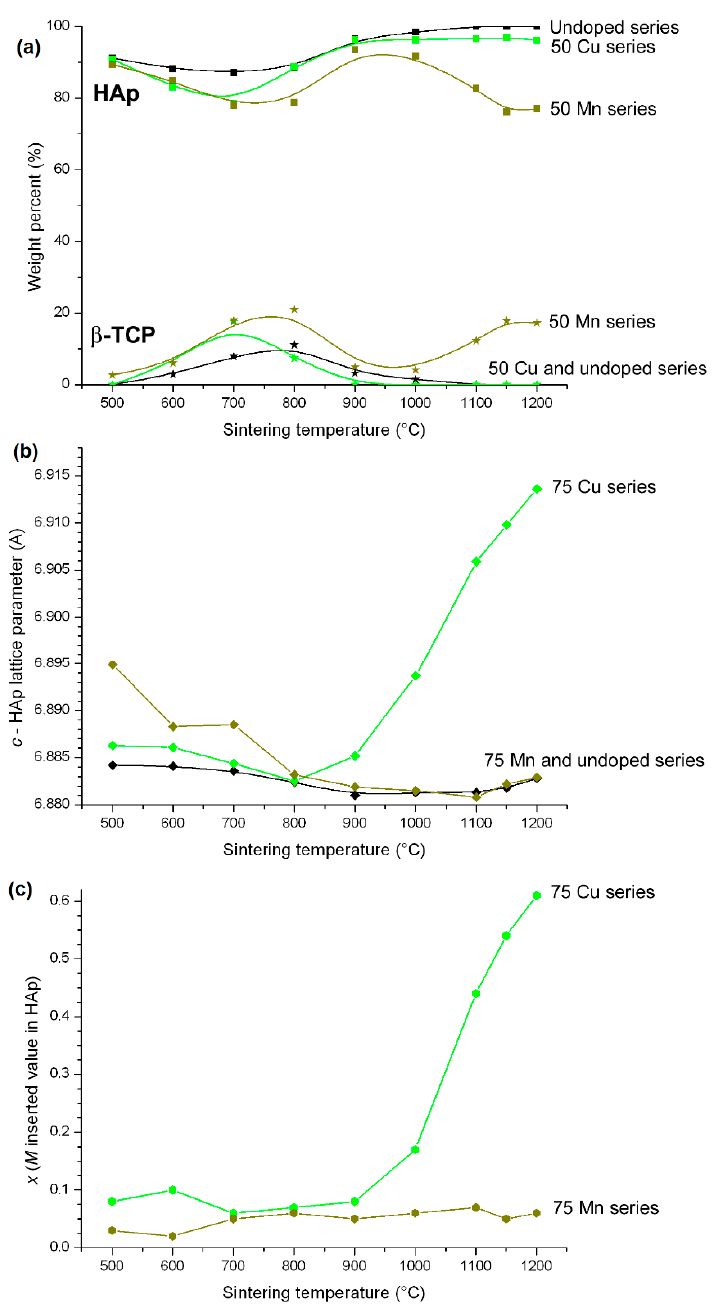
Figure 13. Different behaviors of the 75Cu-T series (green lines) and 75Mn-T series (dark green lines) when heat-treated up to 1200 °C (( a ) weight percent of HAp and β -TCP obtained from Rietveld refinements; ( b ) variation in the hexagonal c axis of the HAp phase; ( c ) variation in the x refined M amount inserted into the HAp structure considering the Ca 10 M x (PO 4 ) 6 (OH) 2 − 2 x O 2 x composition). An undoped series (black lines) is shown for comparison. The lines are only visual guides.